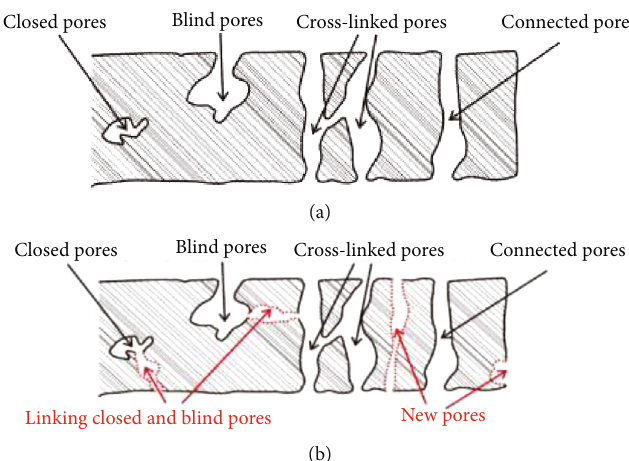
Figure 2: Pore structure models modi fi ed from Giesche (2006): (a) before breakage; (b) after breakage.